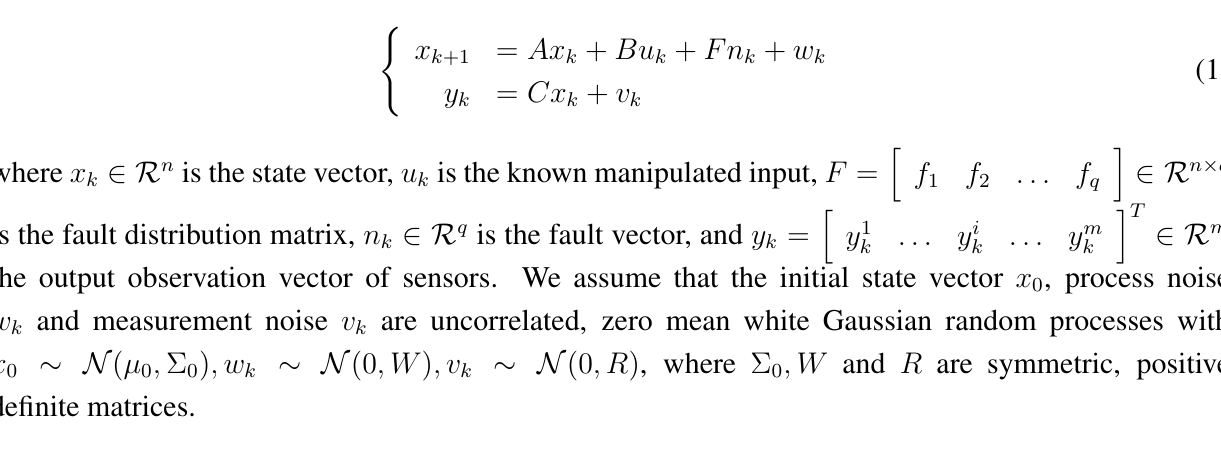
Figure 1. The architecture of NCS with event-triggered